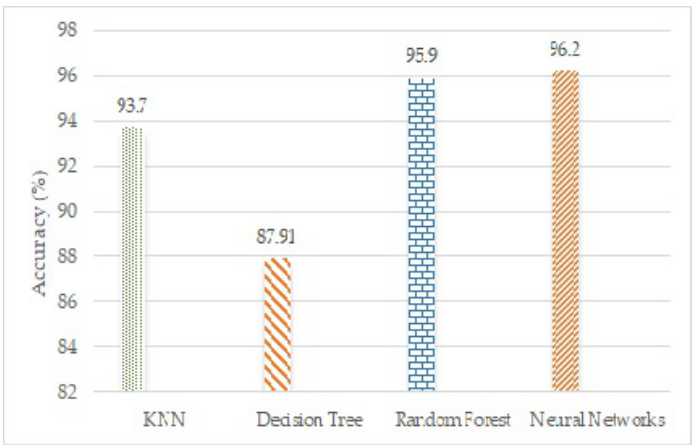
Figure 9. Performance Comparison